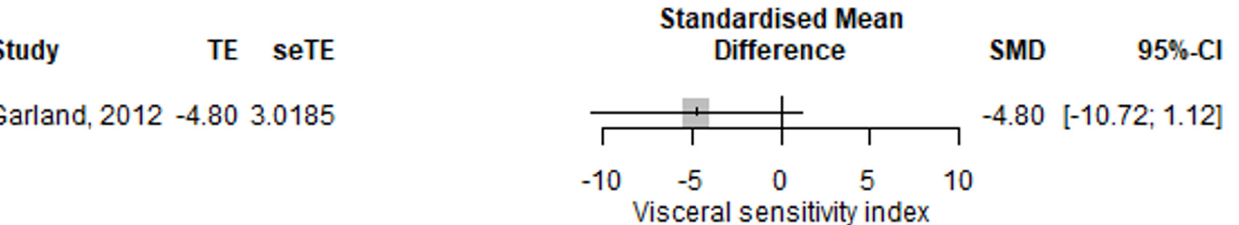
Figure 8. Irritable bowel syndrome visceral sensitivity index scale—standardized mean difference comparison between mindfulness intervention and control. SMD, standardized mean difference; TE, treatment effect as SMD; seTE, standard error of the treatment effect; CI, confidence interval [15].